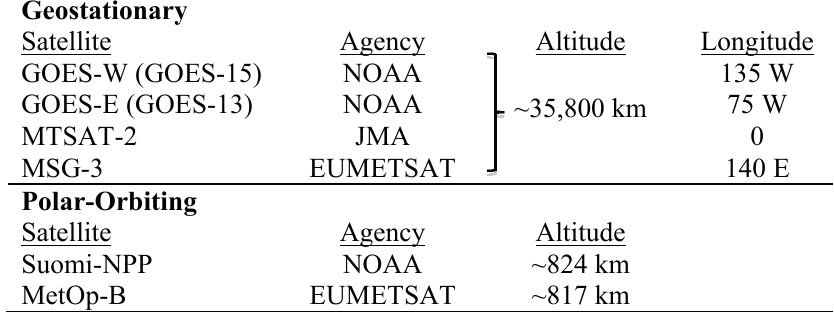
Table 1. Characteristics of geostationary and polar-orbiting satellites currently used in the production of the National Environmental Satellite, Data and Information Service (NESDIS) daily global 5-km geo-polar blended sea surface temperature (SST) analysis. JMA, Japan Meteorological Agency; EUMETSAT, European Organisation for the Exploitation of Meteorological Satellites; GOES-E and -W, Geostationary Operational Environmental Satellite (GOES)-East and -West; MTSAT, Multi-functional Transport Satellite; MSG, Meteosat Second Generation; NPP, National Polar-orbiting Partnership; MetOp-B, Meteorological Operational